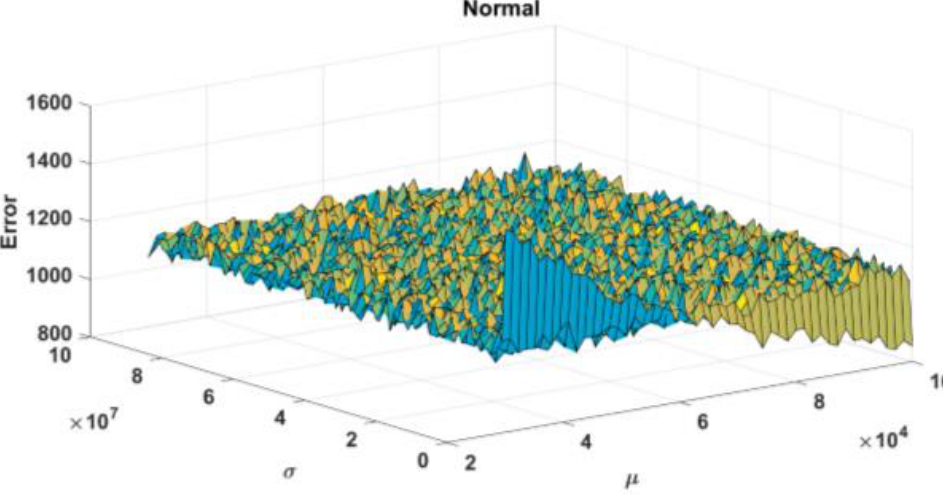
Figure 17. Validation error (Normal): Error—error value, σ—sample dispersion, μ—sample expectation value.